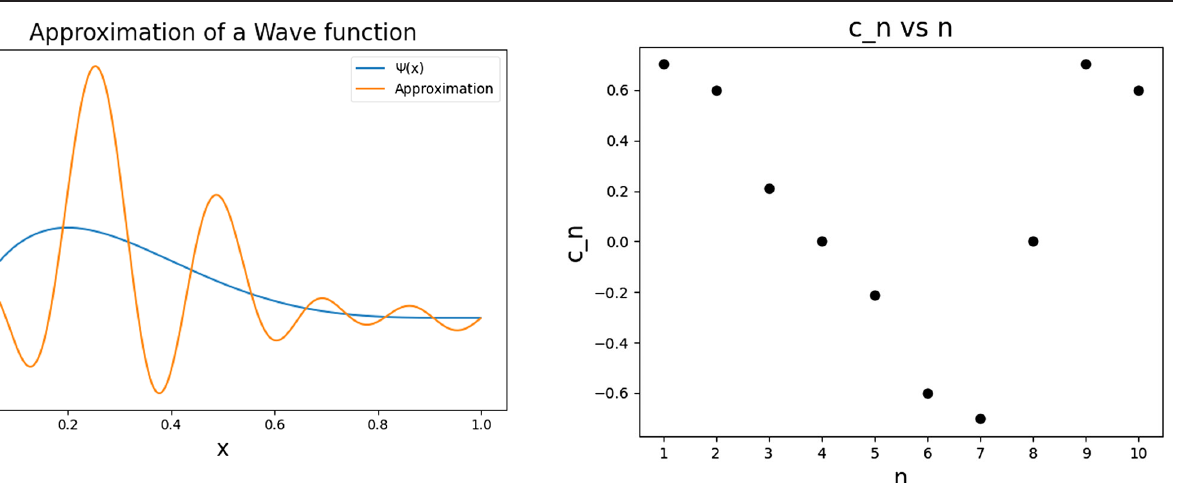
FIG. 5. The inner product of the wave function and an energy eigenstate of a particle in a box, with c n on the vertical axis and the energy level labeled on the horizontal